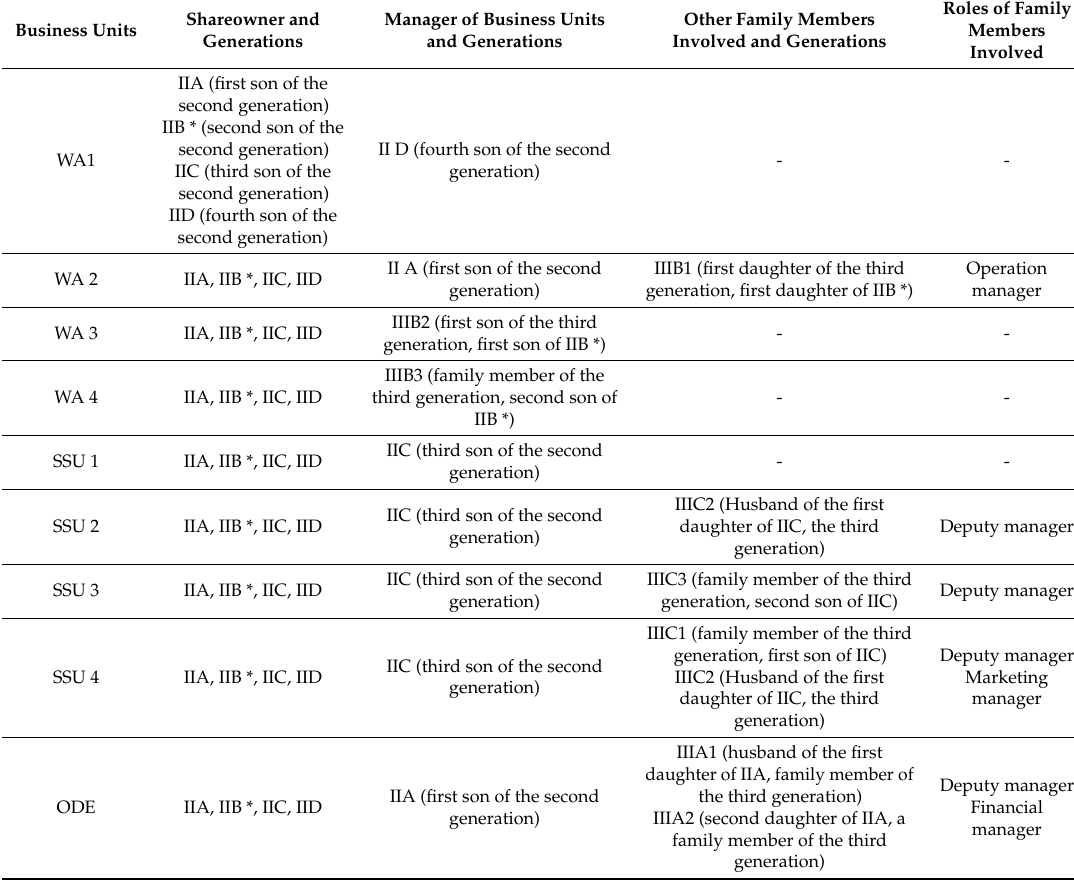
Table 2. Data of shareholders, managers of business units, and roles of family members involved. Business